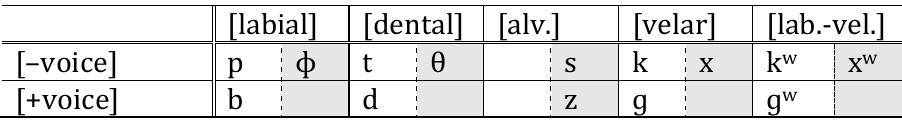
Table 12: The First Germanic Consonant Shift: stage 4 (final, after step